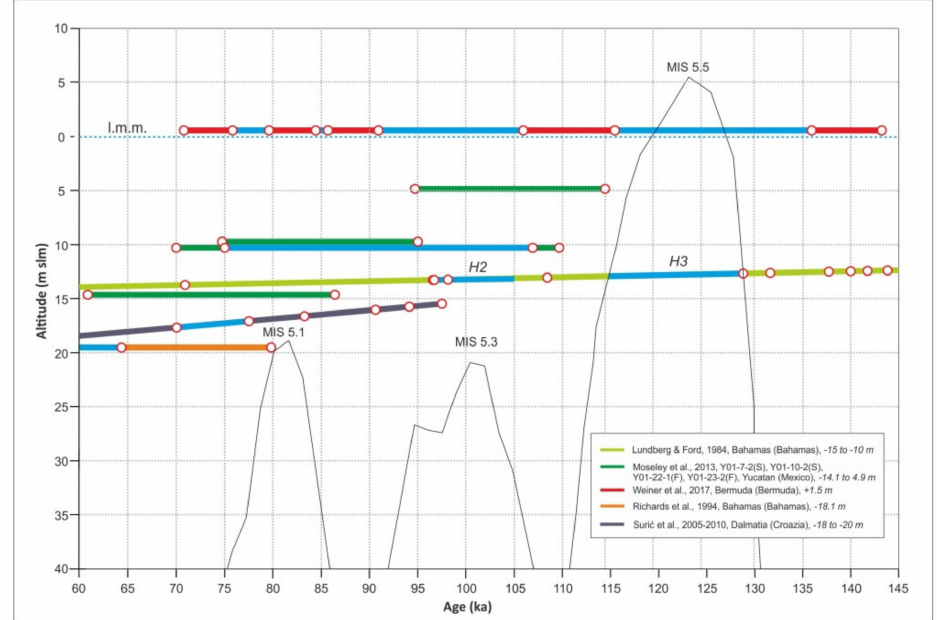
Figure 14. Zoomed in view of part of Figure 13. Fine black line is the global sea-level curve reconstructed by